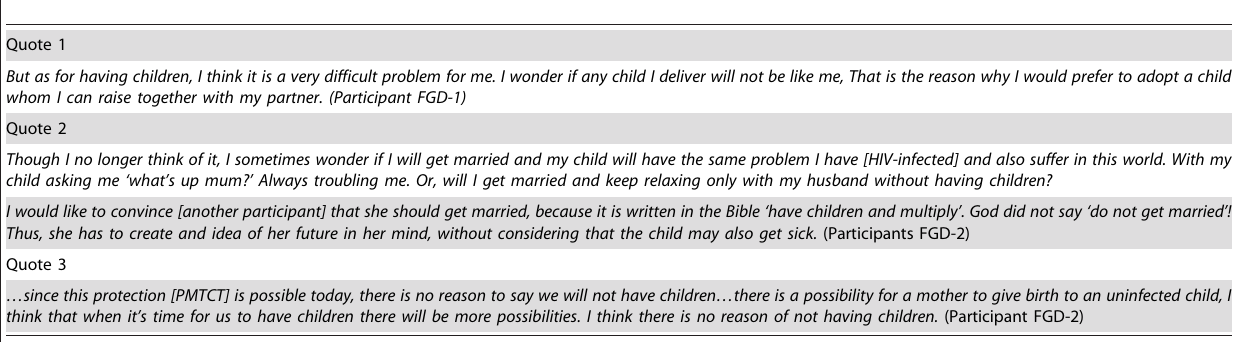
Table 3. Quotes regarding the desire to have